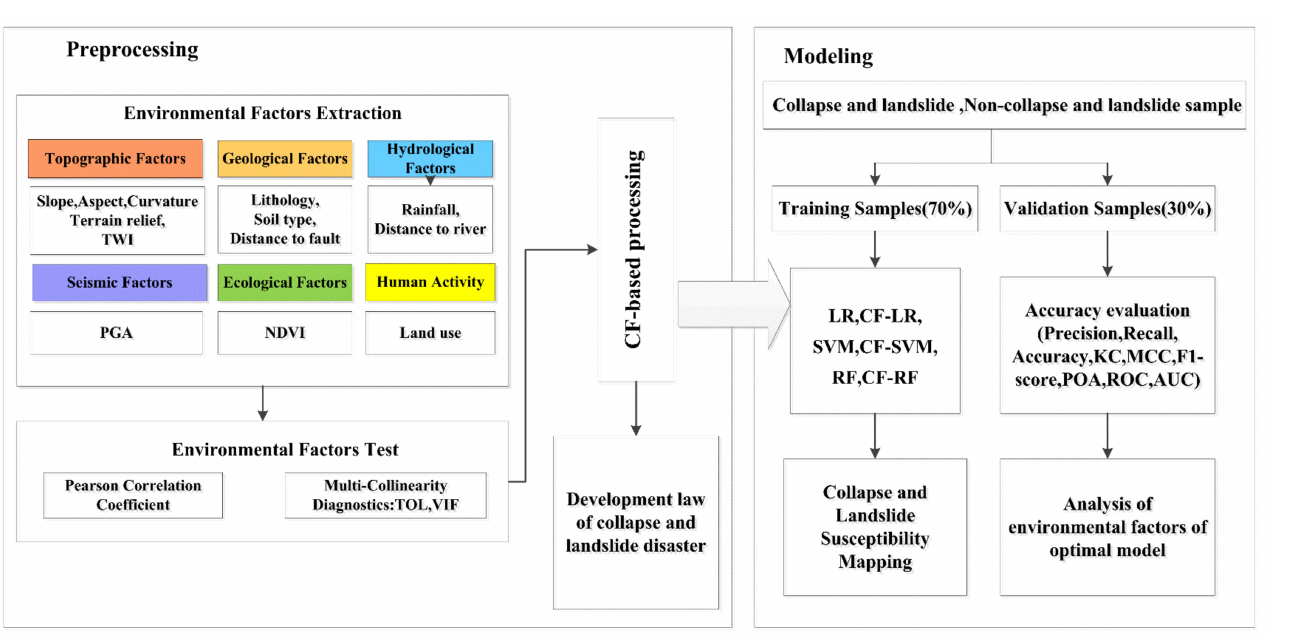
Figure 3. Technical